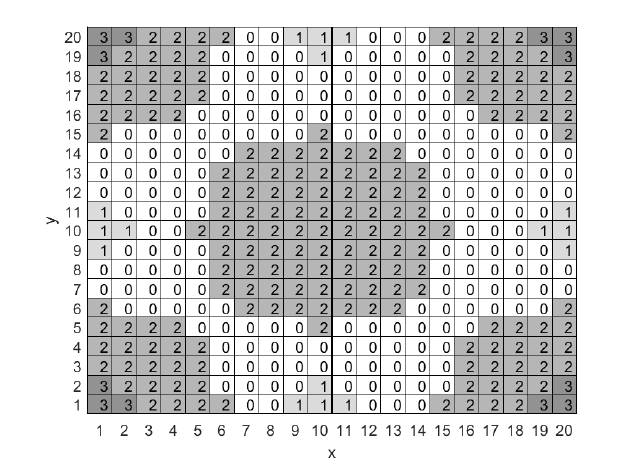
Figure 1. Example of the network availability map for a rectangular surveillance area divided in square-shaped